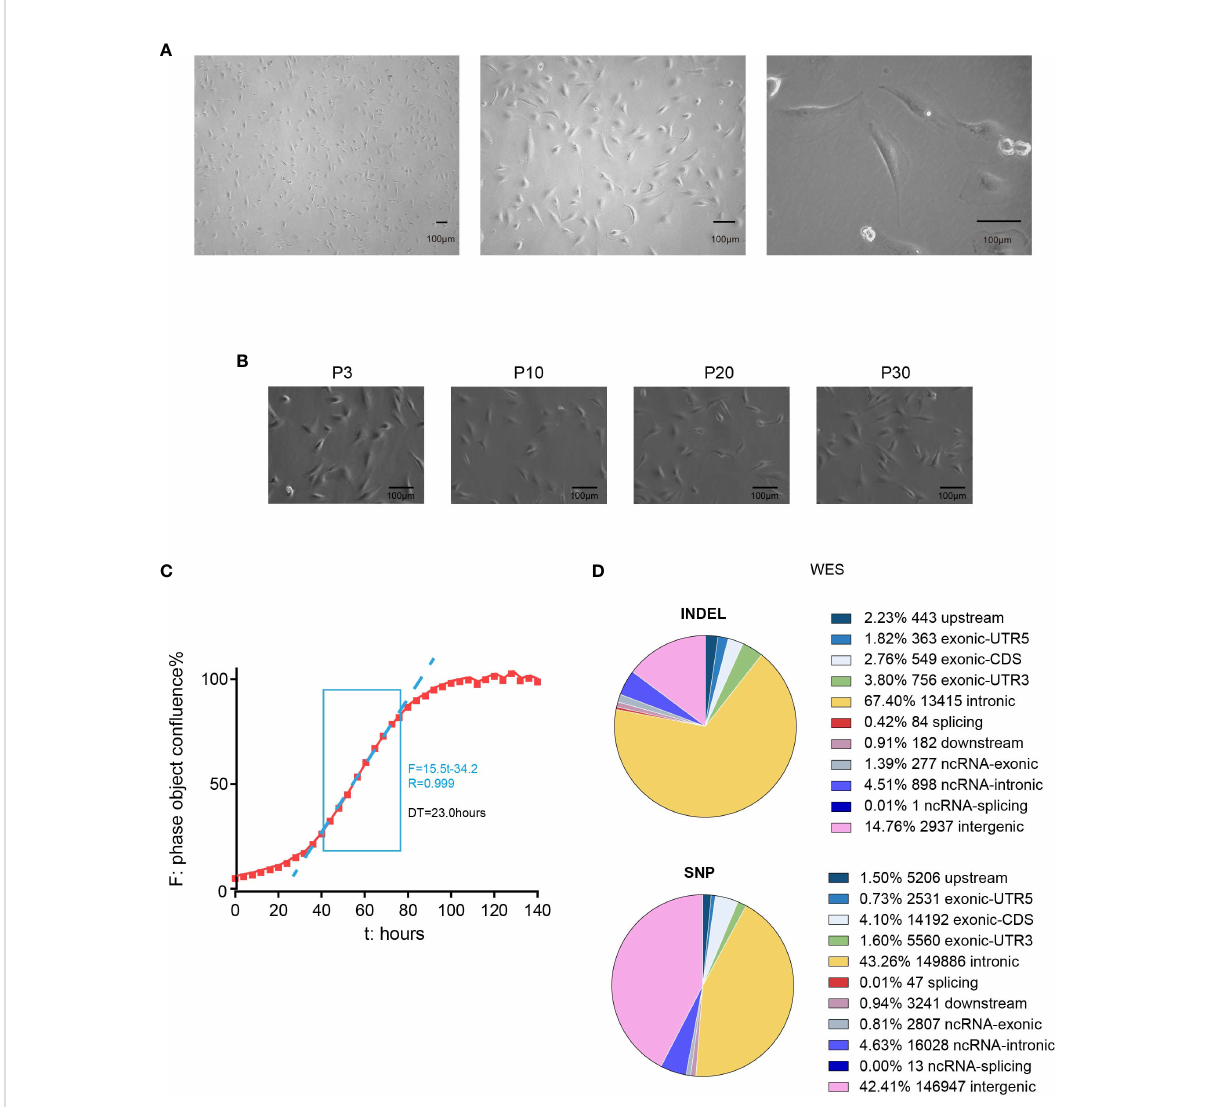
FIGURE 3 Phenotype and genotype of L-2F7 cells. L-2F7 cellular morphology was shown by microscope images with different magni fi cations (A) . The L- 2F7 cellular phenotype remained over 30 passages (P3, P10, P20, P30) (B) . The growth curve was plotted with con fl uence data collected by live cell analysis instrument (C) . Whole-exome sequencing including the single-nucleotide polymorphism (SNP) and indel events was shown based on the different classi fi cations of gene candidates (D) . DT, doubling